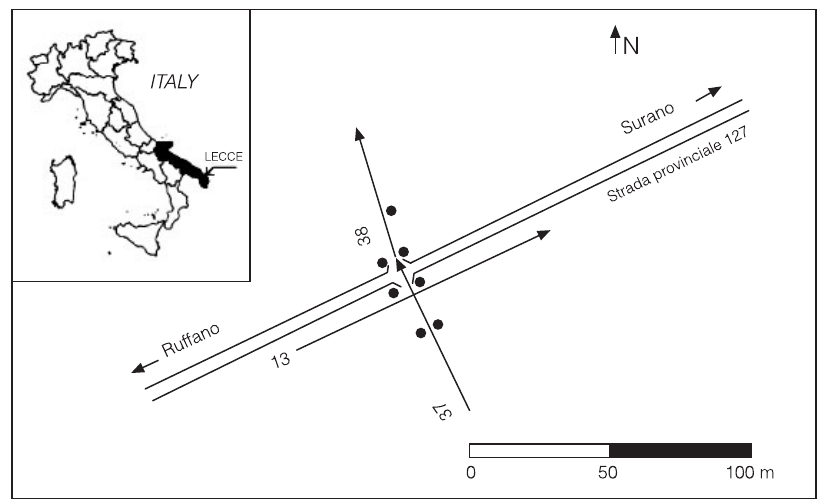
Fig. 1. Example 1: Nociglia, Lecce, Italy – Surface-scattering from trees. Location map of the radar profiles (13 and 37-38) and of the pine-trees